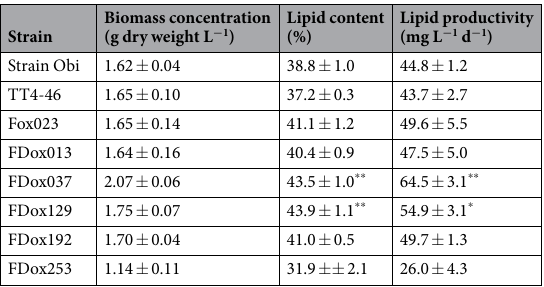
Table 3. Lipid Productivity in FAT1 - and DGAT2d -overexpressed strains. The data are shown as mean ± standard deviation of more than triplicates. The biomass dry weights and lipid contents were determined 14 days after the start of the cultivation. Statistical significance of differences between strain Fox023 and the FAT1 - and DGAT2d -overexpressed strains was tested by Student’s t-test (two tailed), and the results are shown as asterisks. A single asterisk indicates a P-value between 0.01 and 0.05, and two asterisks indicate P <